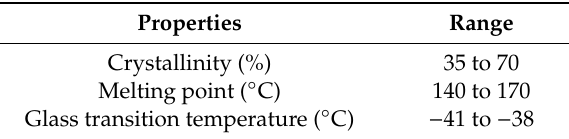
Table 1. Typical Properties of PVDF